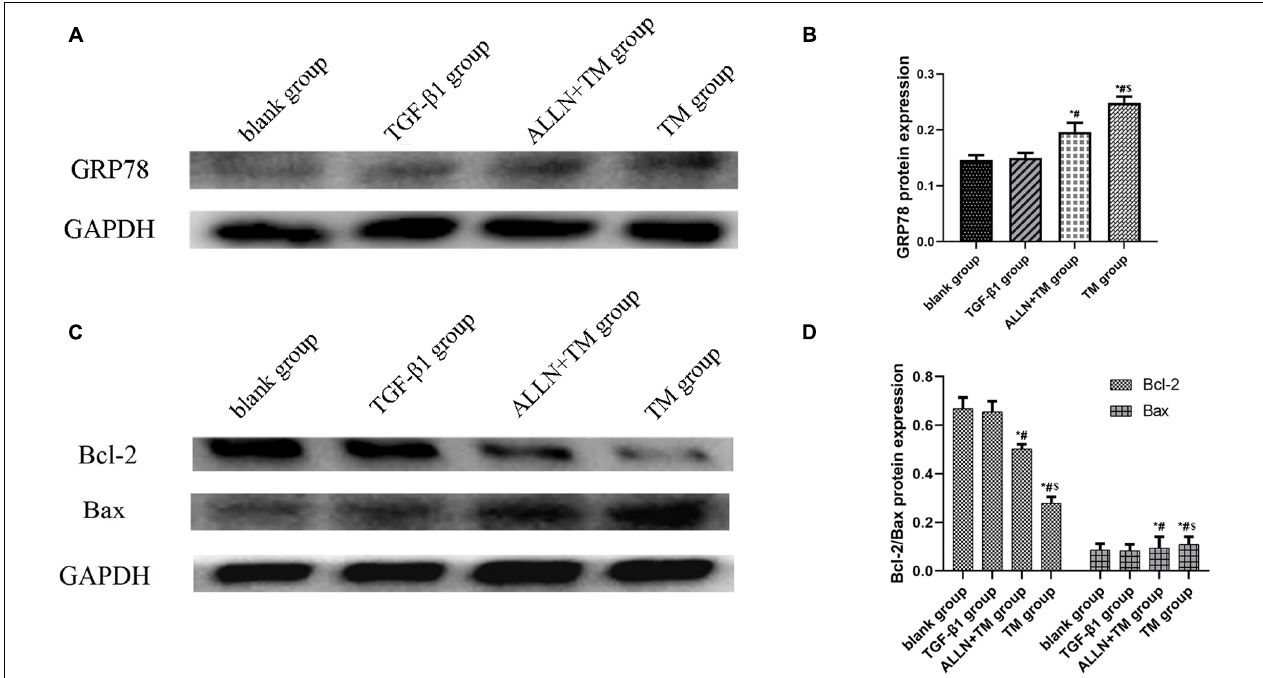
FIGURE 7 | The protein expression level of GRP78, Bax, and Bcl-2 in different groups. The protein expression level of GRP78, Bax, and Bcl-2 were detected by western blot. GAPDH was used as a loading control. (A,C) The gel electrophoresis figure of GRP78, Bax, and Bcl-2 of different groups in HSC. (B,D) Related proteins gray value analysis (* p < 0.05 compared with the blank group; # p < 0.05 compared with the TGF- β 1 group; $ p < 0.05 compared with the ALLN + TM